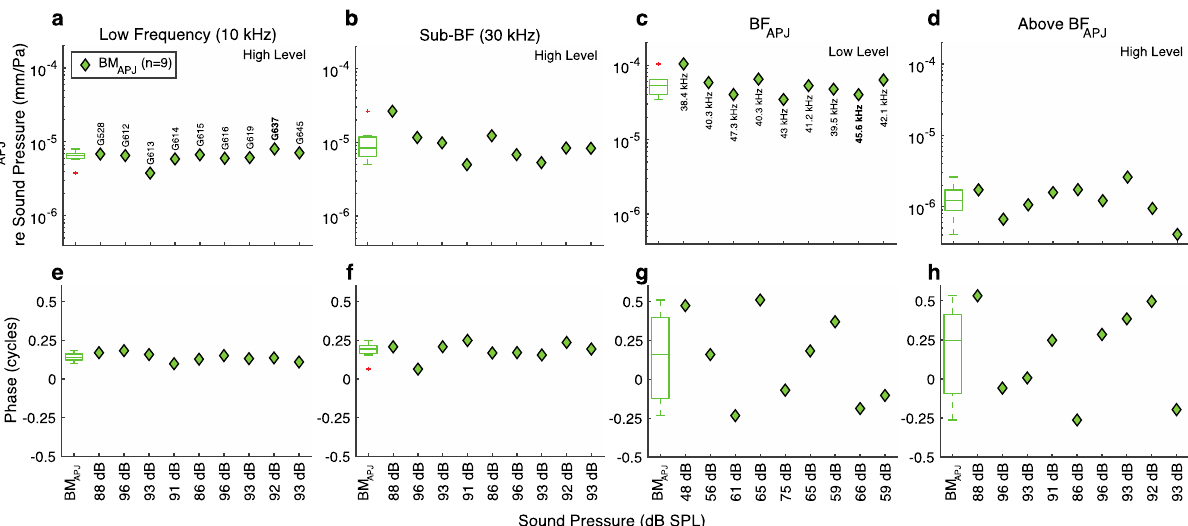
Figure 9. Summary comparisons across animals of the in vivo BM APJ gains with respect to the sound pressure (in units of mm/Pa), for selected frequencies. ( a–h ) The gain magnitudes ( a–d ) and corresponding phases ( e–h ), each with a respective box-and-whisker-plot summary. The frequencies in the first two columns match those of Figs. 5 and 7, however those used in column 3 correspond to BF BM (as shown in Fig. 8) instead of BF RL , and those used in column 4 are a quarter-octave above the frequencies used in column 3. In ( g , h ) phase was shifted up by 2 cycles from those shown in Fig.